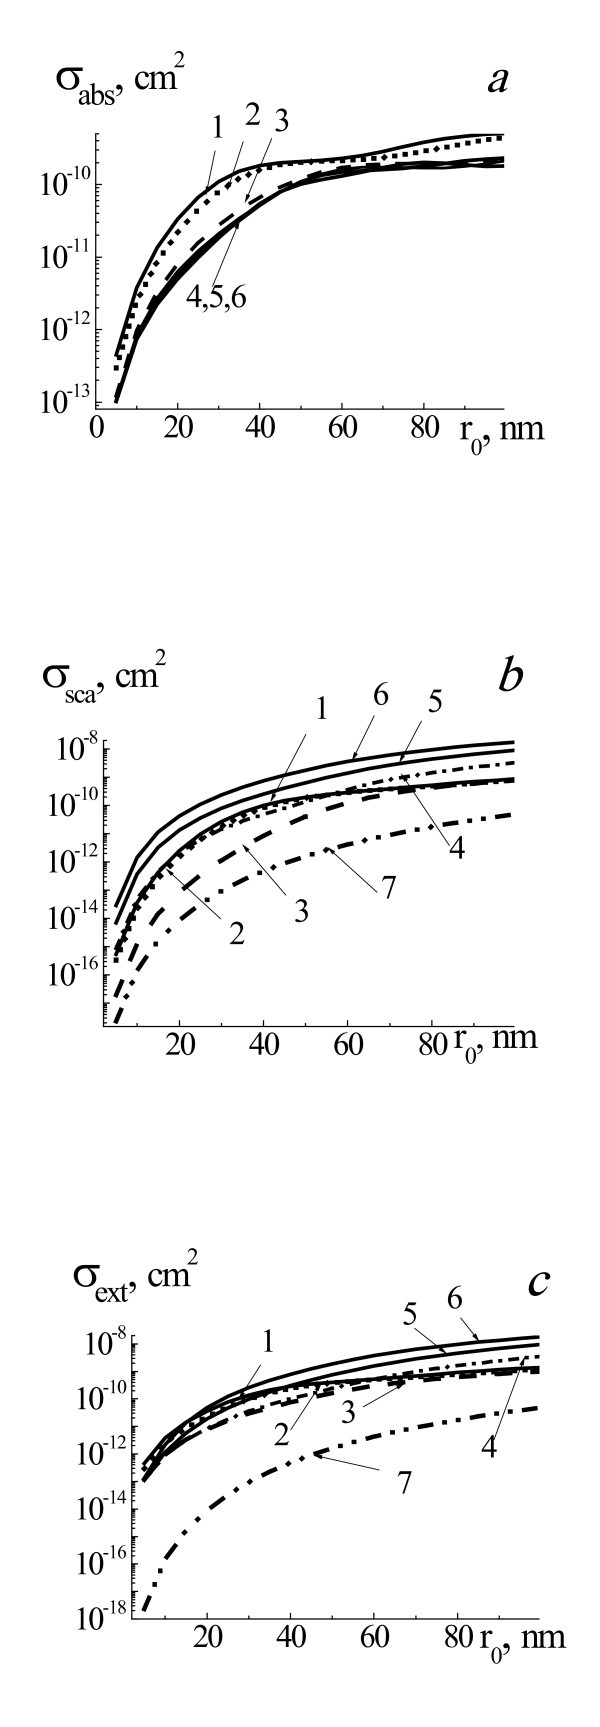
Efficiency cross sections of absorption σabs, scattering σsca, and extinction σext of laser radiation. Efficiency cross sections of absorption σabs (a), scattering σsca (b), and extinction σext (c) of laser radiation with wavelength 532 nm by two-layered spherical system gold NP core and water vapor shell placed in water for the range of NP radii r0 = 5 to 100 nm and radii of system r1 = r0 (1, pure gold NP, straight line) r1 = r0 + 0.1r0 (2, dotted line), r1 = r0 + 1r0 (3, dashed line), r1 = r0 + 2r0 (4, dashed-dotted line), r1 = r0 + 3r0 (5, straight line), and r1 = r0 + 4r0 (6, straight line), and for homogeneous vapor bubble with r0 (7, dashed-double dotted line).